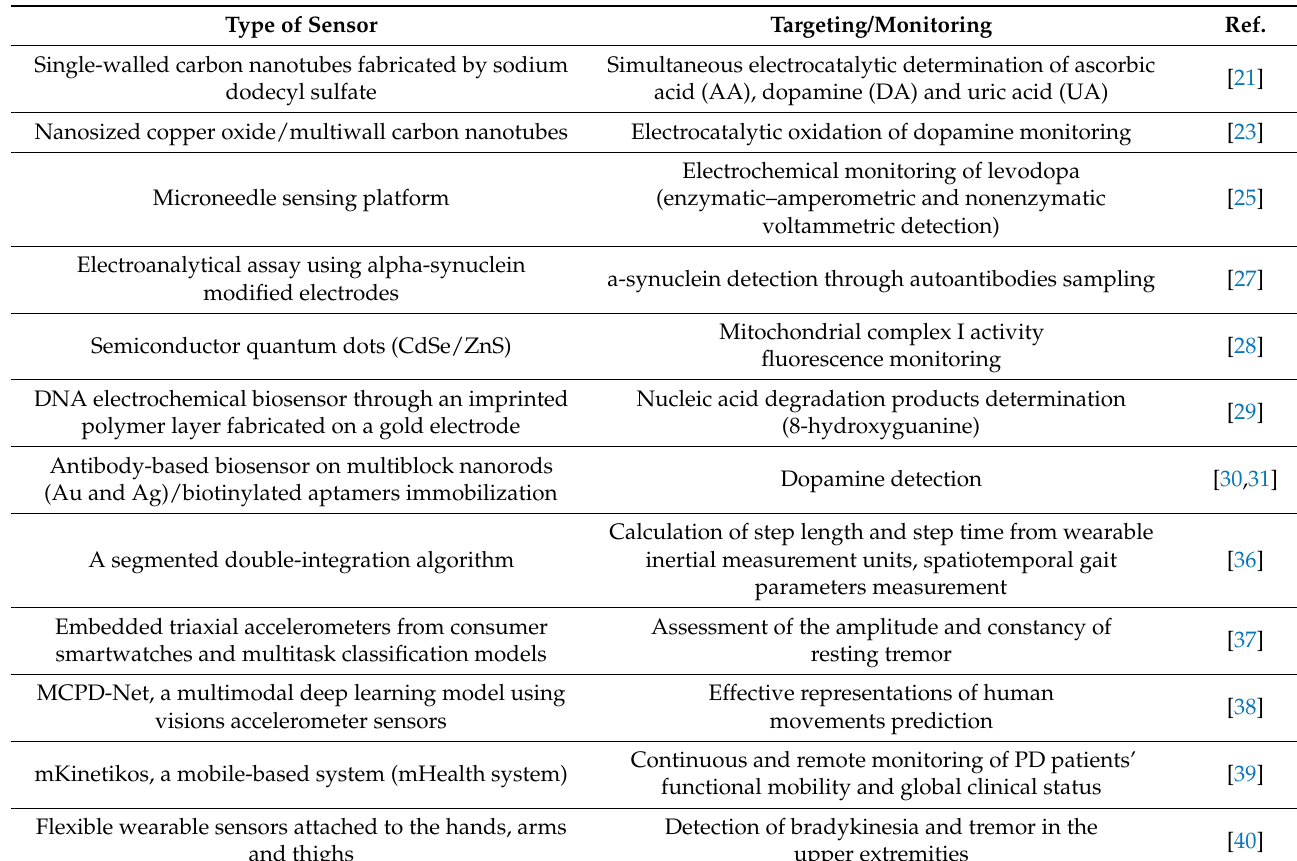
Table 1. Sensor-based approaches in PD